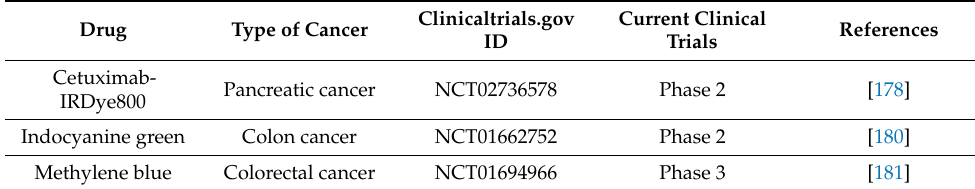
Table 4. Exogenous contrast agents with PA properties in clinical